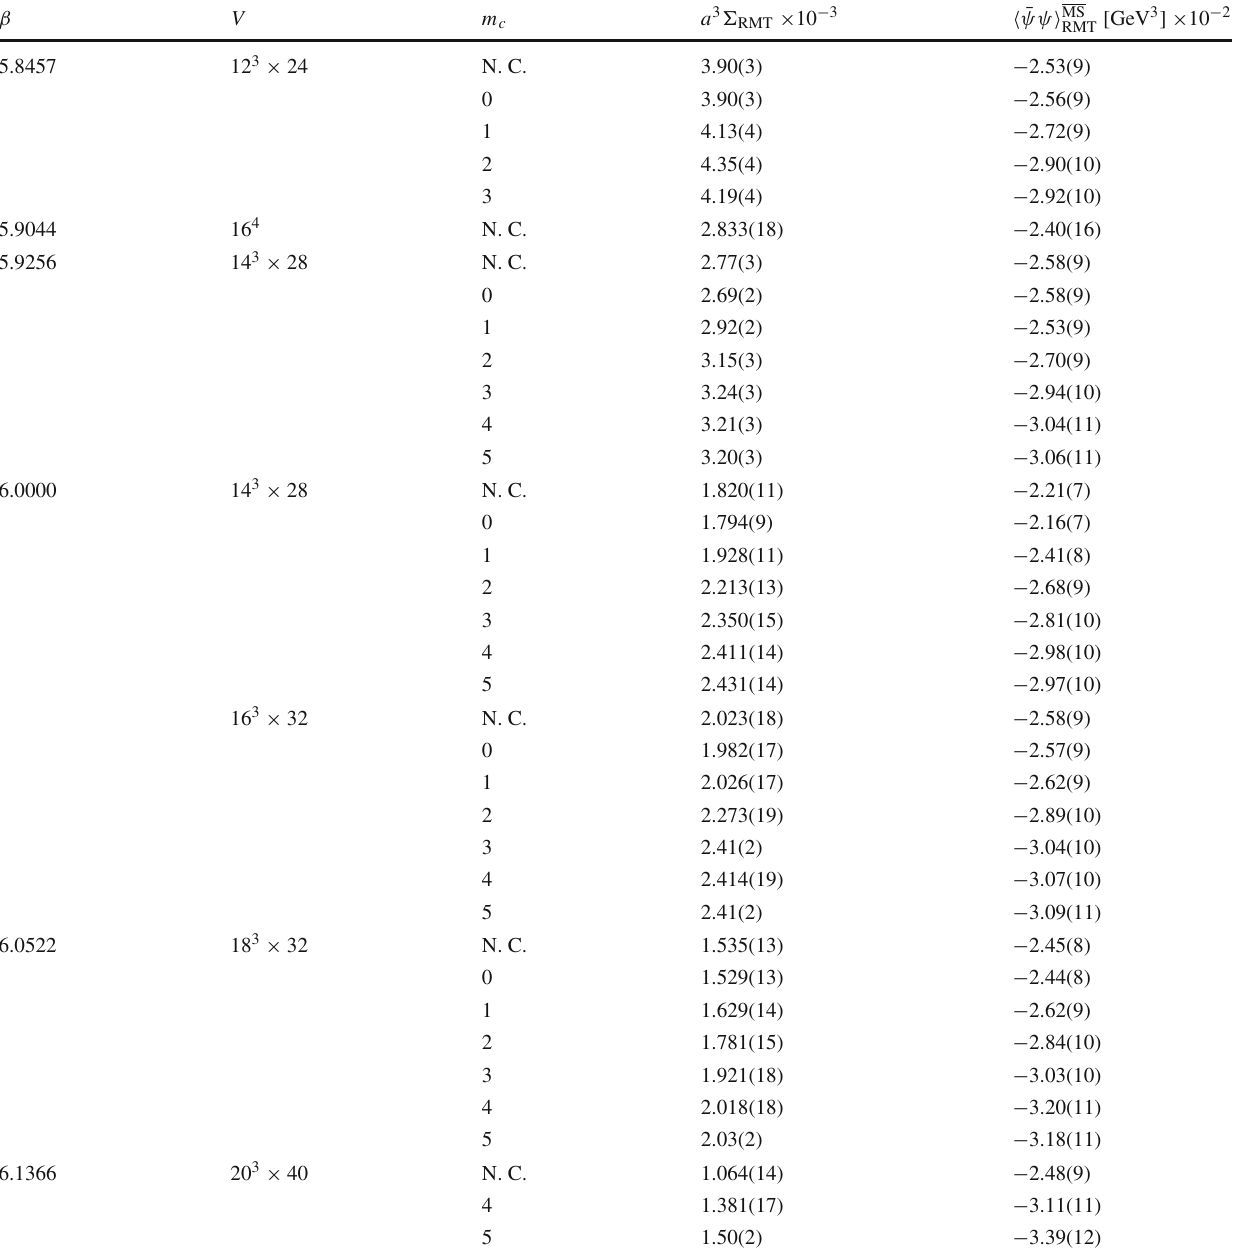
2 [GeV]. The renormalized chiral condensate of β = 5 . 9044 , V = 16 4 is estimated with ˆ Z S = 1 . 08 ( 7 ) which is obtained by the interpolation in the MS-scheme at RMT of the numerical results of ˆ Z